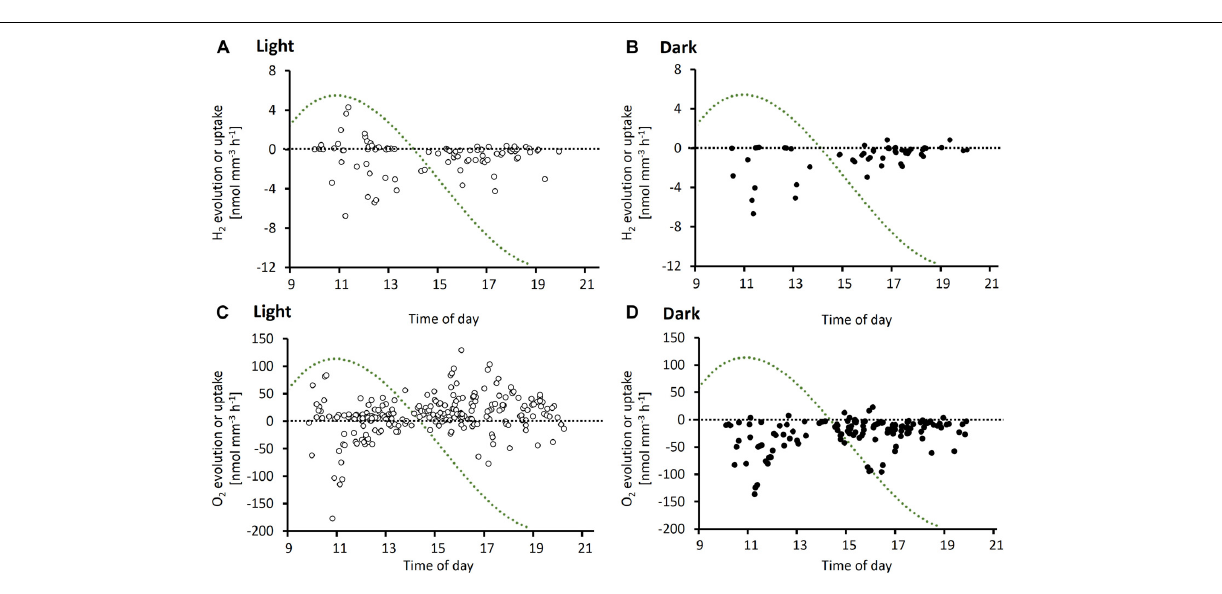
FIGURE 2 | Diel cycle of potential H 2 evolution or uptake rates (A,B) and O 2 evolution or uptake rates (C,D) based on depth profiles measured on Trichodesmium colonies in the light (A,C) and dark (B,D) . Data points represent single measurements of H 2 or O 2 profiles. Measurements were performed on a total of 130 and 23 colonies for O 2 and H 2 , respectively. X -axis denotes time of measurement. Note that all data shown are net rates, with positive numbers reflecting net evolution of H 2 or O 2 by a specific colony, and negative numbers reflecting net uptake of H 2 or O 2 , respectively. The green dotted line represents a typical diel cycle in N 2 fixation (arbitrary units), which was obtained by a third order polynomial fit to an average of N 2 fixation rates measured by Berman-Frank et al. (2001), Milligan et al. (2007), Kranz et al. (2010), and Eichner et al. (2014). N 2 fixation rates were normalized to the diel maximum in the respective study. For laboratory studies, start and end of the 12 h light period were aligned to the times of sunrise (6 am) and sunset (7 pm), respectively, in Eilat at the time of the